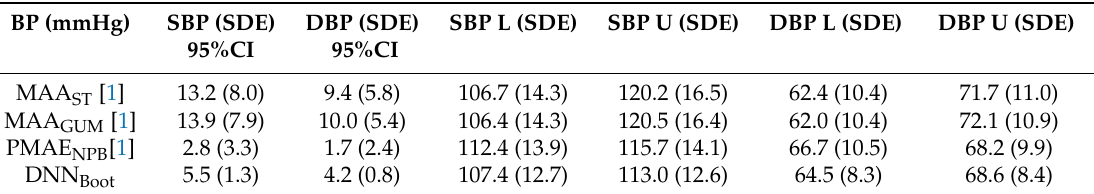
Table 7. Summary of the CL of the SBP and DBP for nurse measurements, the proposed DNN regression model and the conventional methods, n (=85) is the number of subjects and SDE is a standard deviation of error; L and U are the lower and upper limits, respectively.